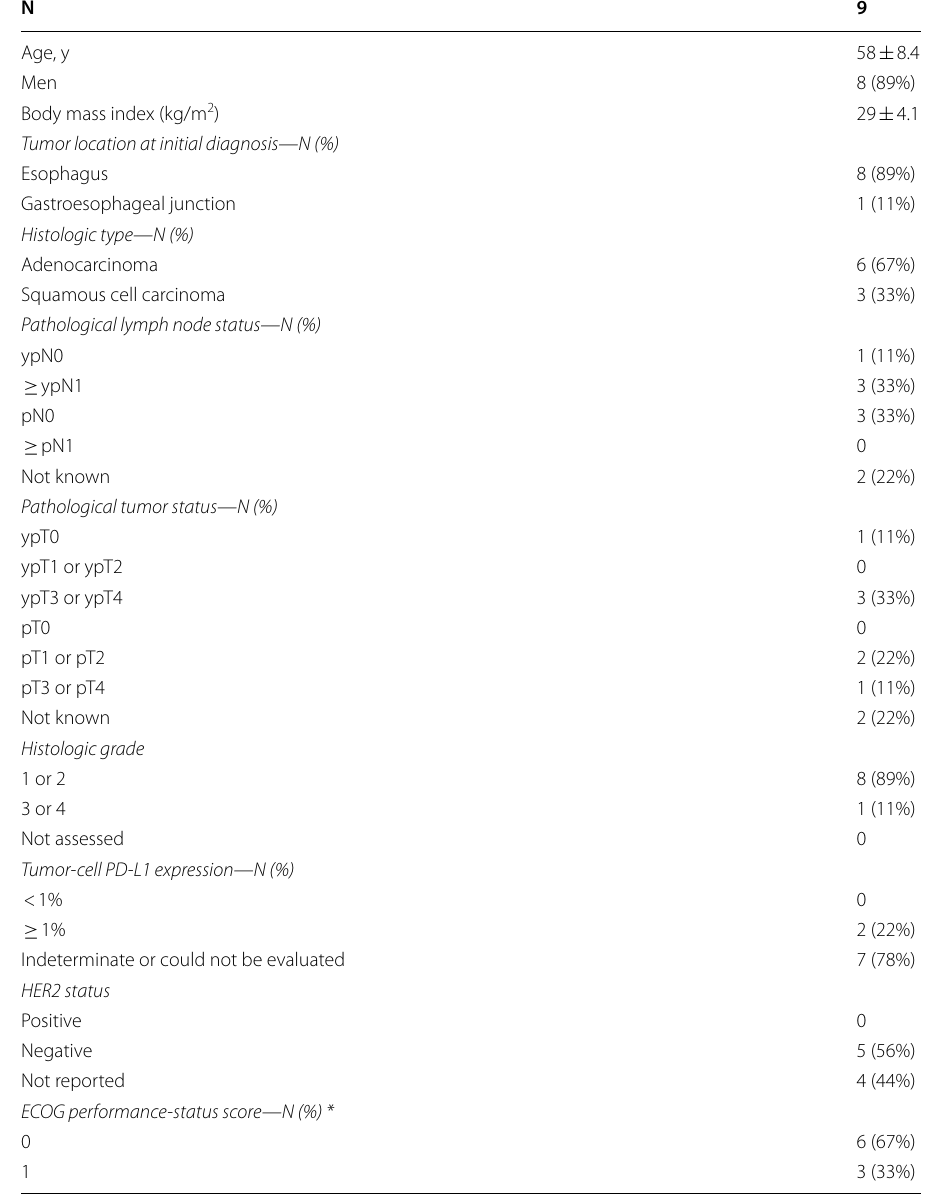
Table 1 Baseline